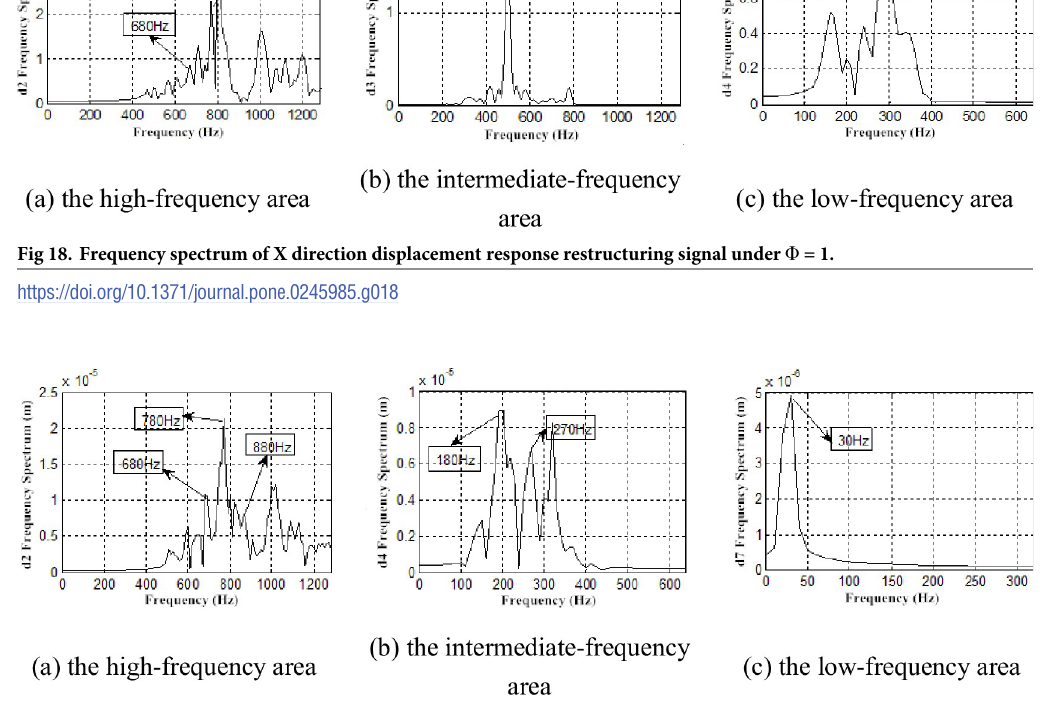
Fig 19. Frequency spectrum of X direction displacement response restructuring signal under F = 0.605.